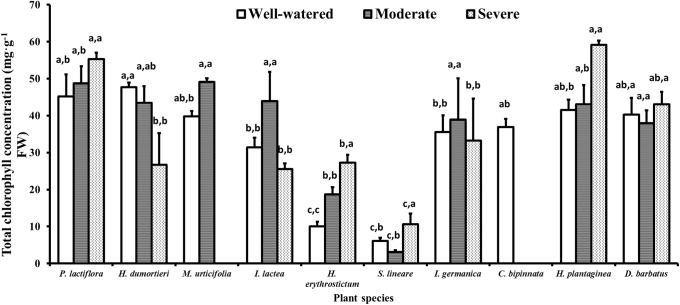
Variance of the total chlorophyll concentration in the ten species during the drought stress tests.The histogram shows the mean values. Above the histogram, the lowercase letters before the commas indicate statistical significance among the different plant species, and the lowercase letters after the commas indicate statistical significance among the well-watered, moderate and severe drought stress treatments. The different lowercase letters indicate a significant difference at P<0.05.